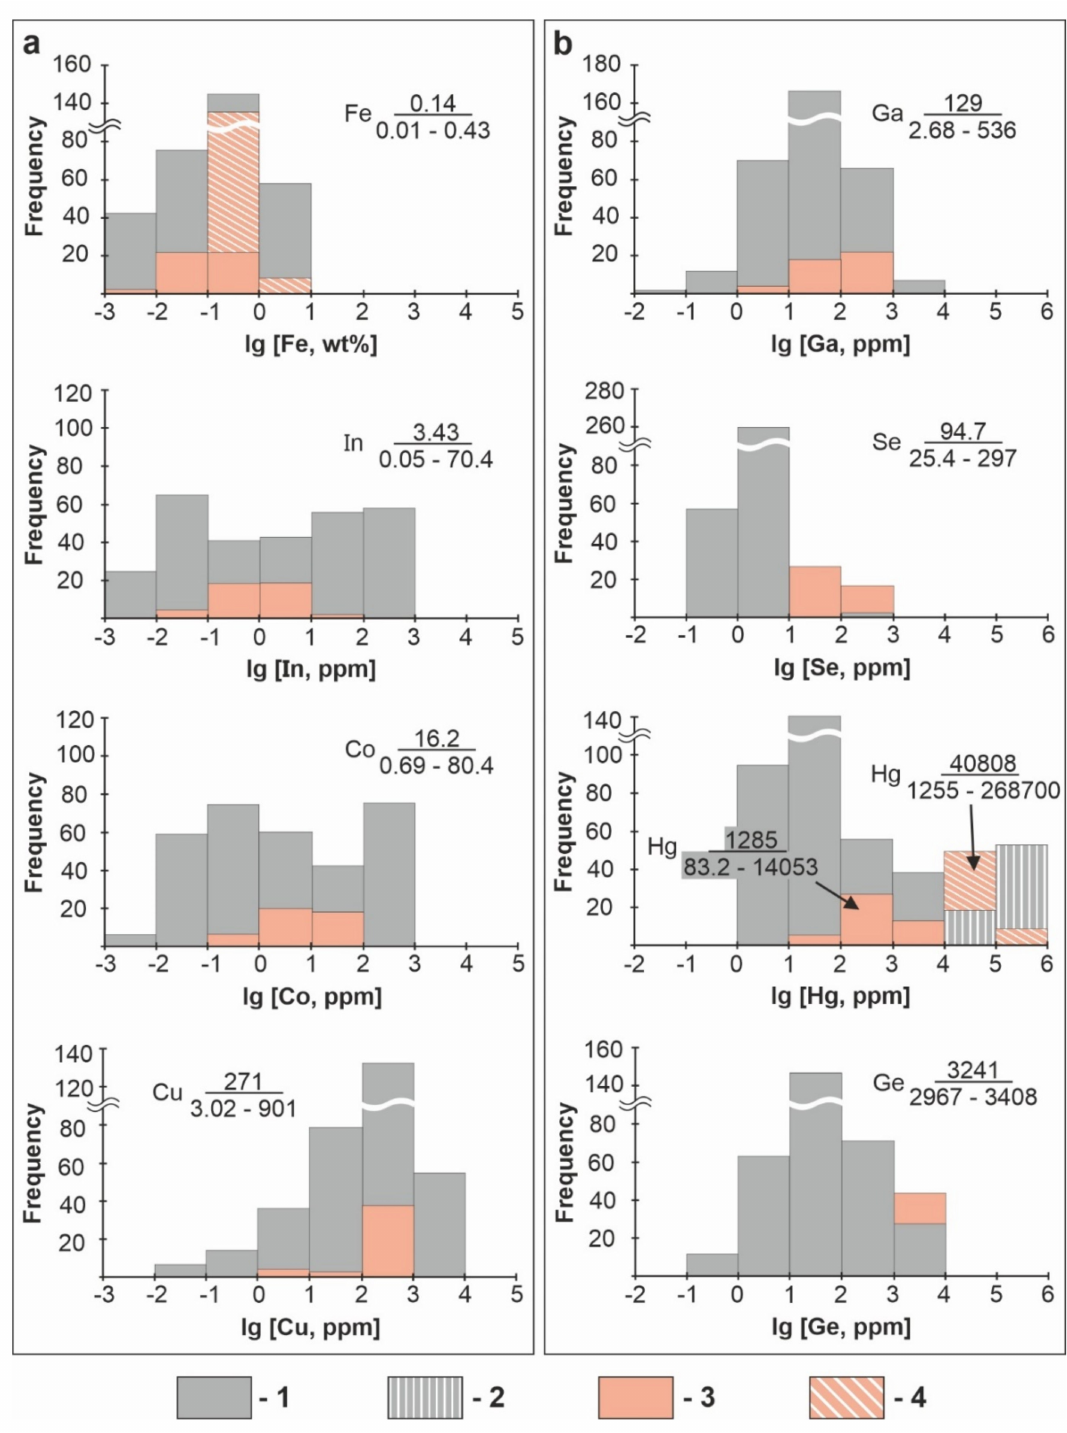
Figure 22. Trace-element contents in sphalerites from Pugachev and South Sakhalin MVs compared to those of low- temperature (T < 200 ◦ C) sphalerites from different deposits worldwide: ( a ) comparable amounts, ( b ) abnormal amounts. 1 = trace-element contents in sphalerites (LA-ICPMS data) from Vein-type and Mississippi Valley-type Pb-Zn deposits of Romania [1], China [8], Germany [16] and Iran [105]. 2 = Hg contents in sphalerites (EDS-WDS data) from different Hg deposits of Canada [1], Russia, Ukraine, Mongolia, Kyrgyzstan, Uzbekistan [3], and China [82]. 3 = trace-element contents (LA-ICPMS data) in Sakhalin MVs sphalerites. 4 = Hg contents (EDS-WDS data) in Sakhalin MVs sphalerites. The numbers next to the histograms are element contents: average values above the bar and the averaging range below the